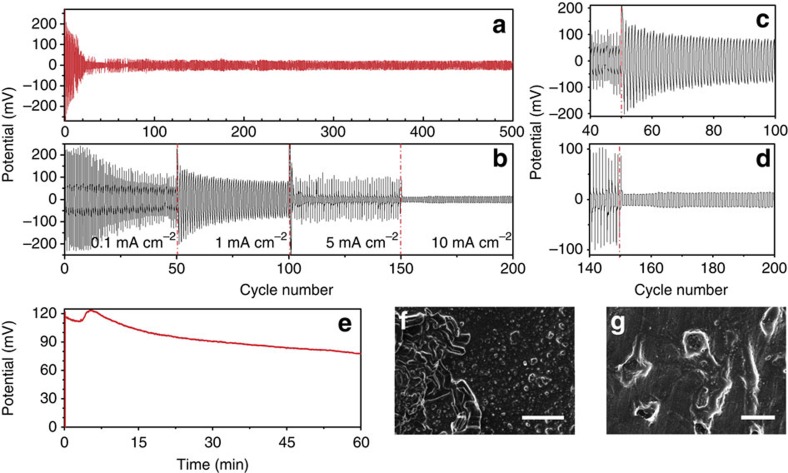
Characterization of Li|LiFSI/[C3mPyr+][FSI−]|Li cells after 12-day pretreatment.Cycled for 500 charge/discharge cycles at (a) 2.0 mA cm−2, (b) ramping 0.1 to 10 mA cm−2 for 50 cycles per current density and (c) highlighting the effect of ramping the current density from 0.1 to 1.0 mA cm−2 and (d) 5.0 to 10 mA cm−2. (e) The first charge/discharge of a symmetrical cell and the corresponding SEM images of the Li anode after the initial (f) plating (scale bar, 10 μm) and (g) stripping of lithium (scale bar, 50 μm).